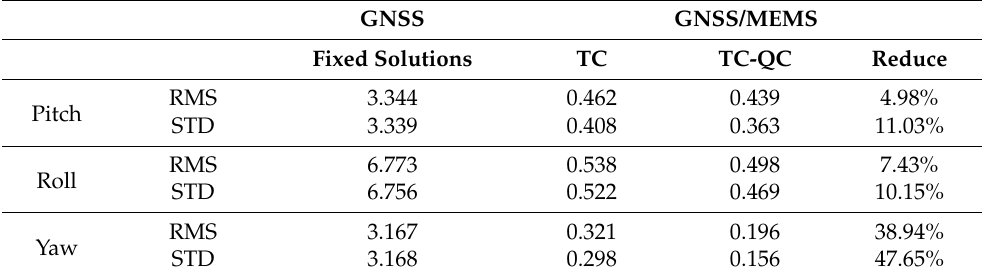
Table 3. Statistics of attitude errors (Unit: degree).